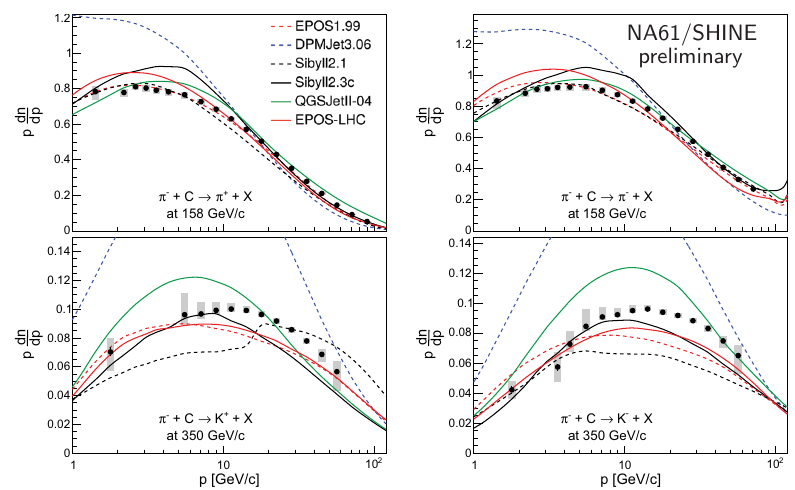
Figure 6: Spectra of π ± and K ± mesons in π − + C collisions at beam momenta of 158 GeV / c and 350 GeV / c as a function of momentum p . The statistical uncertainties are represented by bars and the systematic ones by grey bands. Regarding models see text.